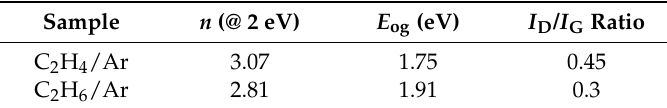
Table 3. Parameters of amorphous carbon samples obtained from spectroscopic ellipsometry and Raman